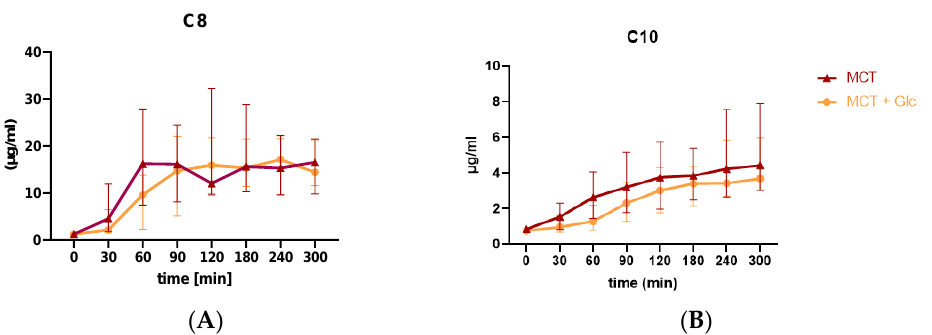
Figure 5. Median (IQR) plasma MCFAs: ( A ) plasma octanoate throughout the 5 h test day; ( B ) plasma decanoate throughout the 5 h test .